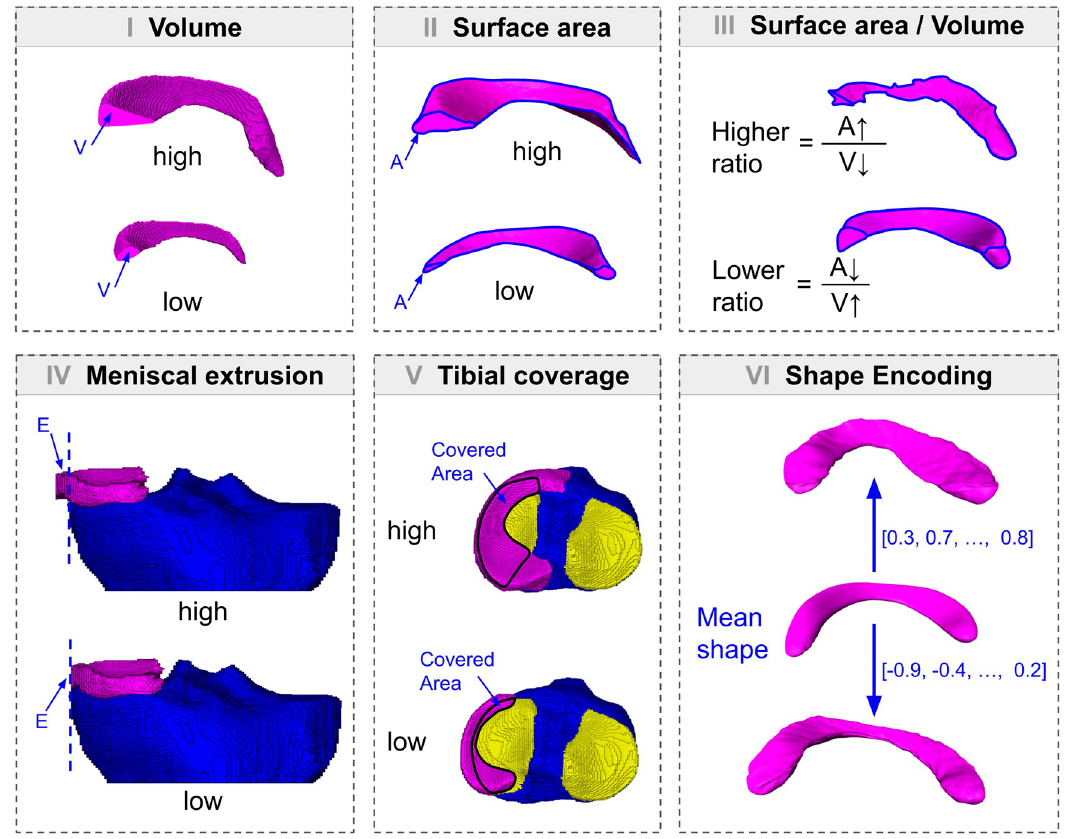
Fig 3. Computation of KOA features. KOA features are exemplarily shown for the medial meniscus (purple), tibial bone (blue) and tibial cartilage (yellow). MEAS features are computed based on segmented voxels and surfaces generated thereof. For MEAS, (I) volumes are computed for femoral cartilage, medial/lateral/total tibial cartilage, and both menisci, (II) surface areas are computed for both menisci, (III) ratio of volume and surface area is computed for both menisci, and (IV) meniscal extrusion is computed for both menisci. (V) Tibial coverage is computed for both tibial plateaus. (VI) LDSE features are computed for femoral bone, tibial bone, and medial/lateral meniscus representing individual shapes relative to the mean shape of the analyzed population.